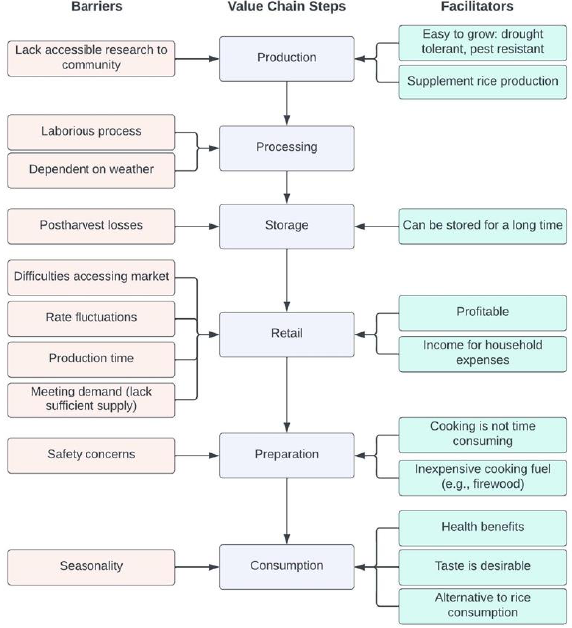
Figure 4. Overview of barriers and facilitators to the production and consumption of finger